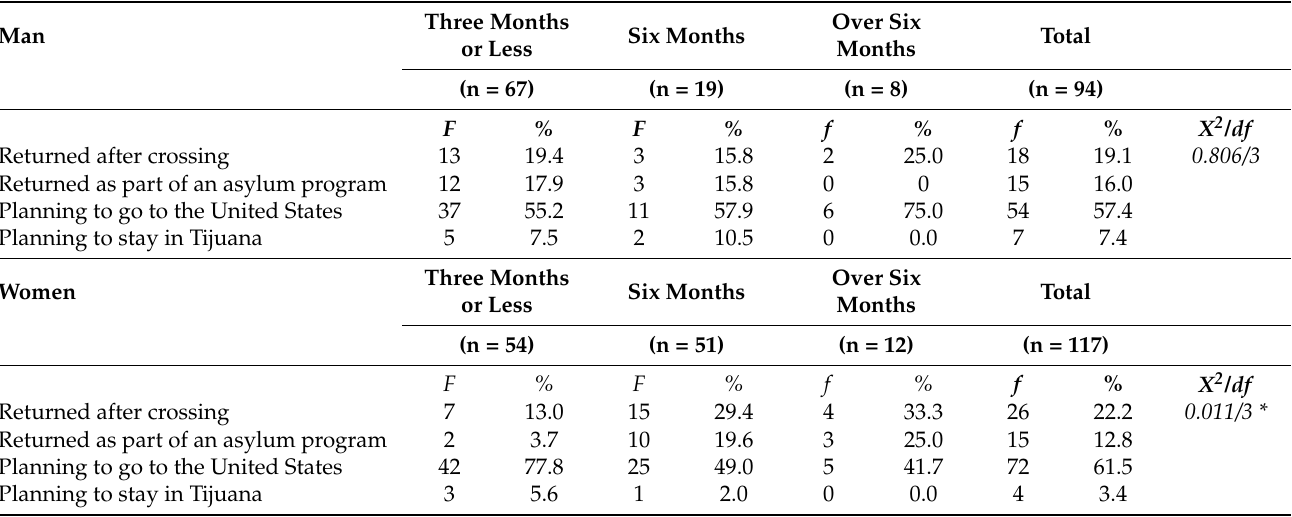
Table 6. Reasons for being in Tijuana and length of stay.